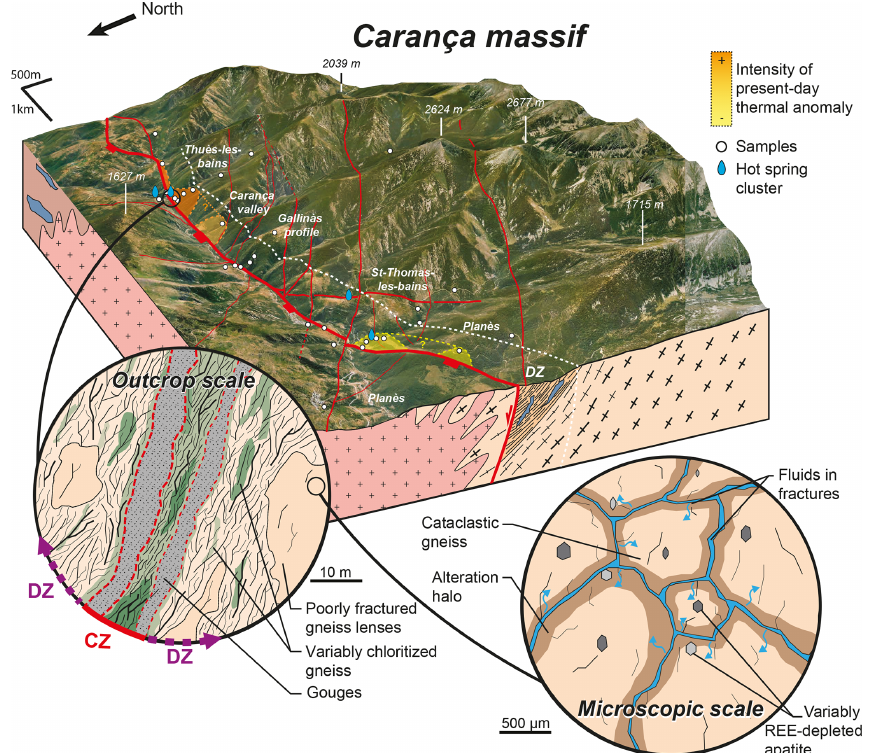
Figure 15. Schematic 3D block of the surface distribution of the present-day thermal anomalies in the Têt fault footwall based on AHe dating and REE analyses, with zooms into the fault zone at the outcrop and microscopic